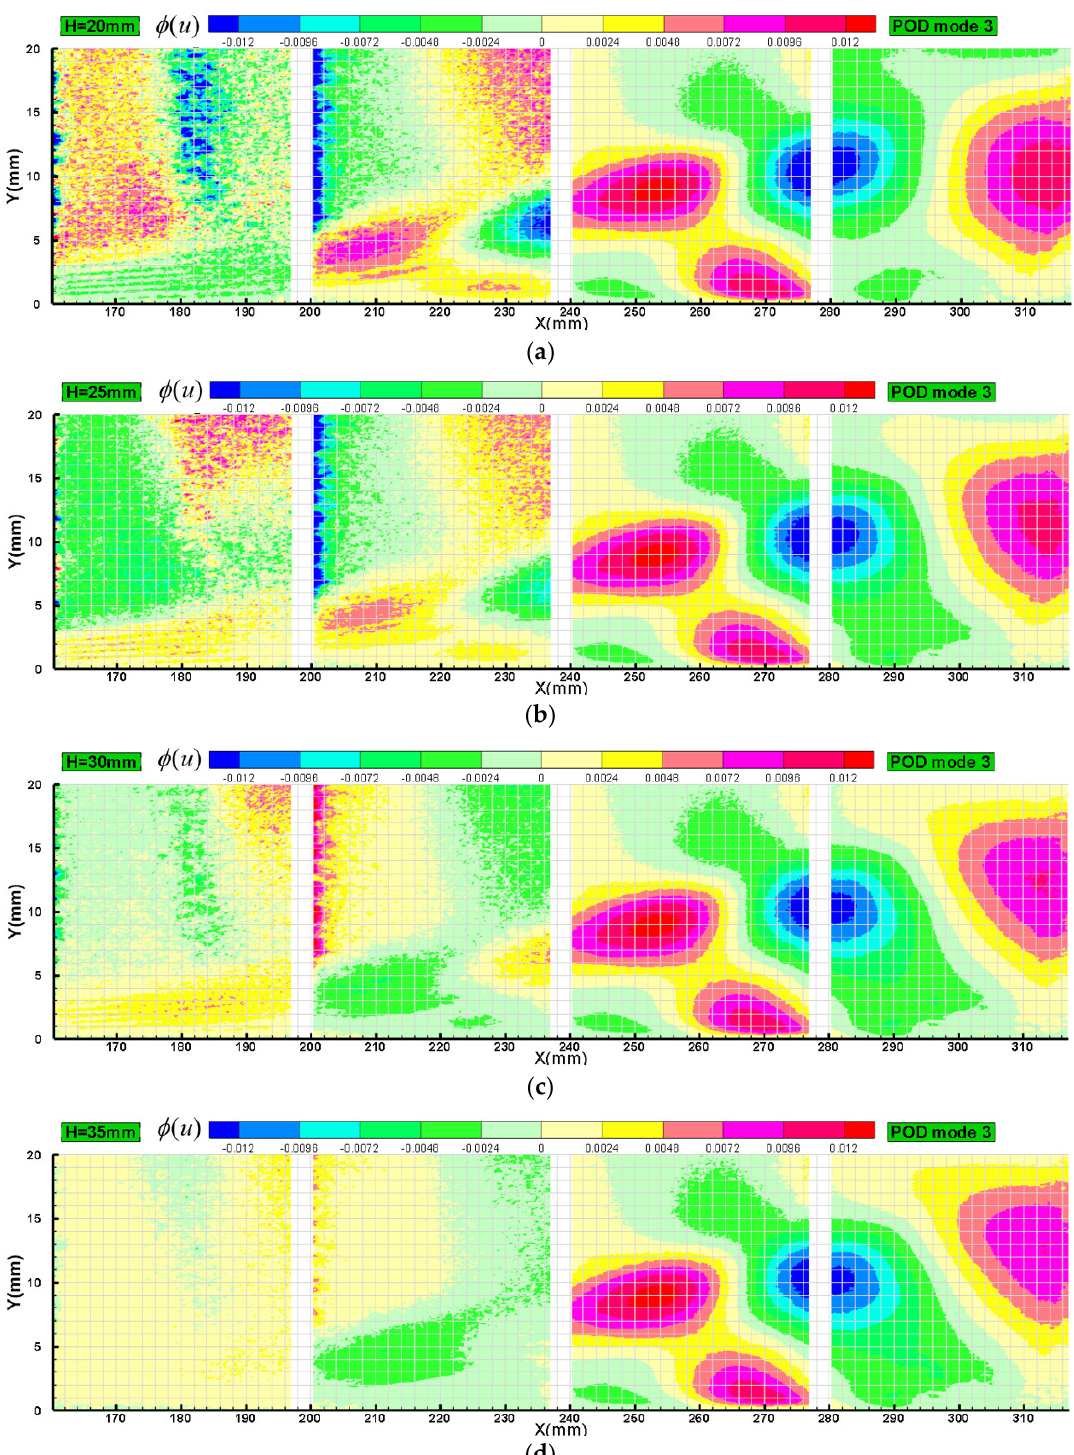
Figure 3. The third-order mode of the streamwsie velocity with different spanwise decomposition region size: ( a ) H = 20 mm; ( b ) H = 25 mm; ( c ) H = 30 mm; and ( d ) H = 35 mm.